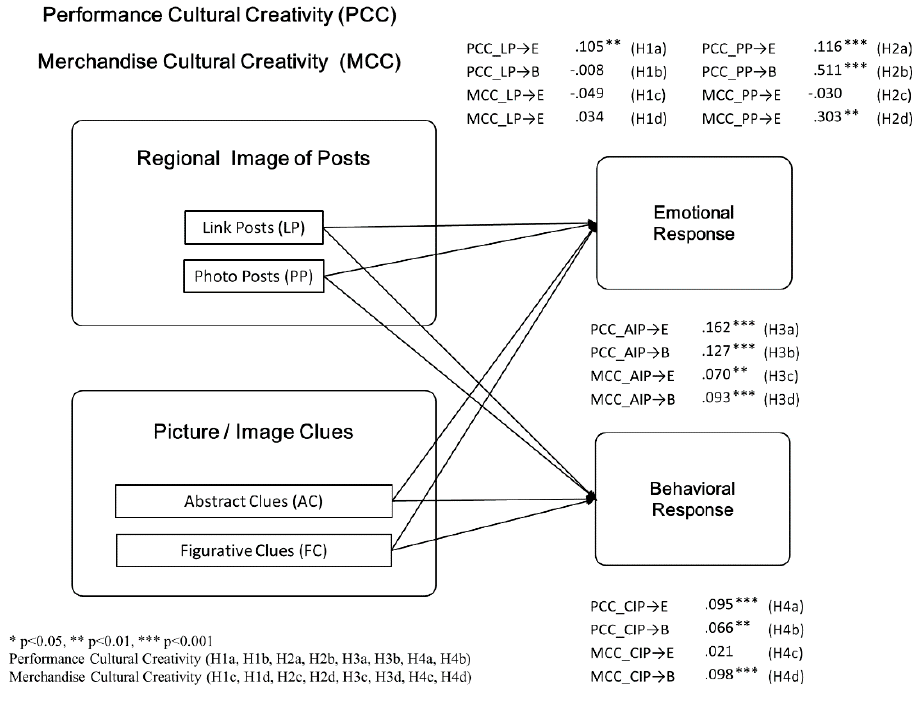
Figure 2. Model results.